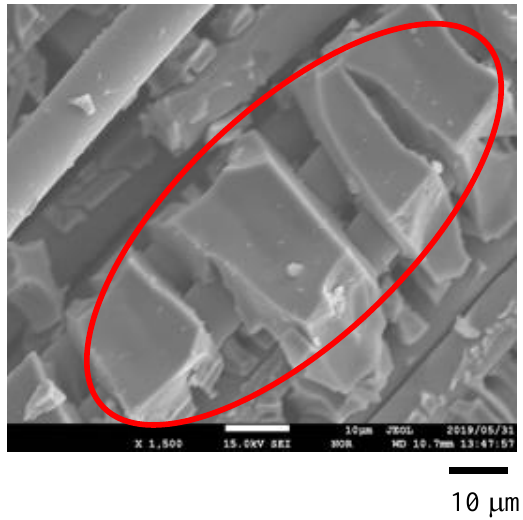
/ TiO Figure 2. SEM result of Pd/TiO 2 film coated on netlike glass disc. Figure 2. SEM result of Pd 2 film coated on netlike glass Figure 2. SEM result of Pd/TiO 2 film coated on netlike glass disc.